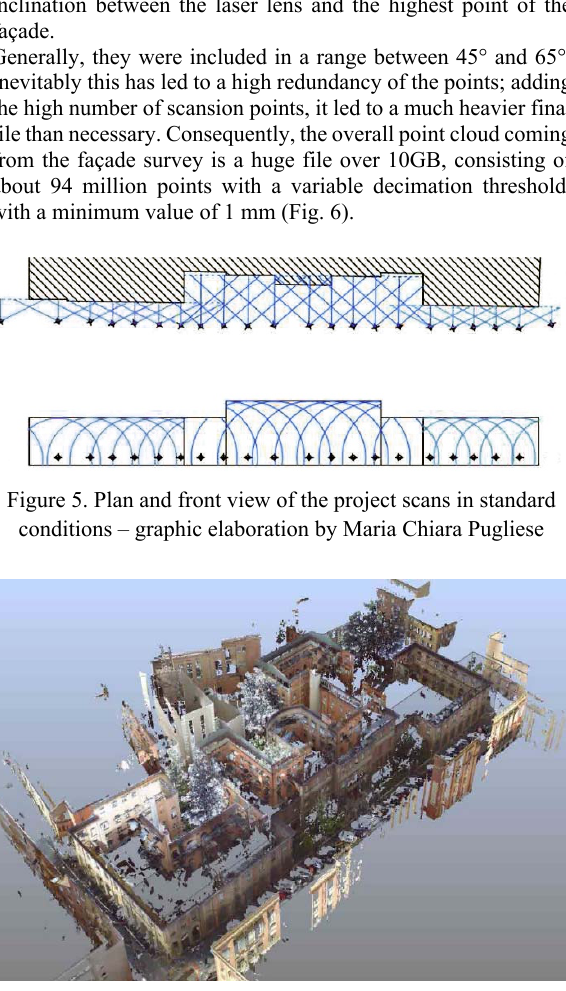
Figure 6. Visualization of the point cloud using “ Faro Scene” – graphic elaboration by Davide Prati The overlap of the corner cones is high, always higher than 25%, with average values of around 46.5%, while the average error of the points is 3.14mm (Tab. 2).